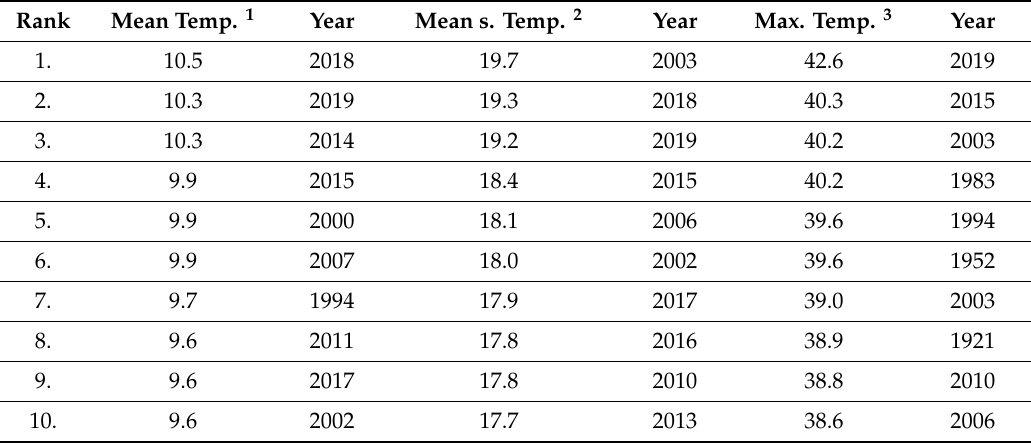
Table 1. Ranking of the 10 warmest years in Germany since 1881 (temperature in ◦